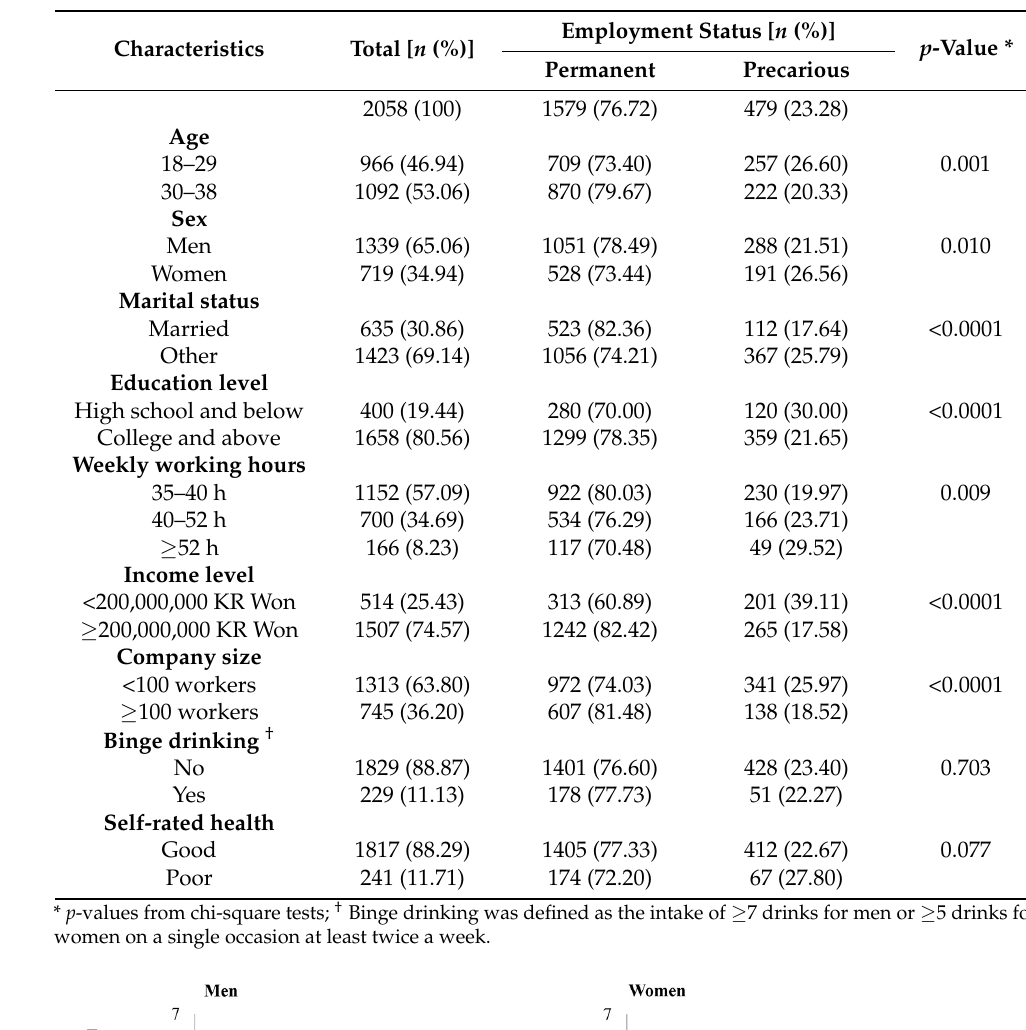
Table 1. Characteristics of all the study participants at the baseline (Wave 10) and differences between employment status.